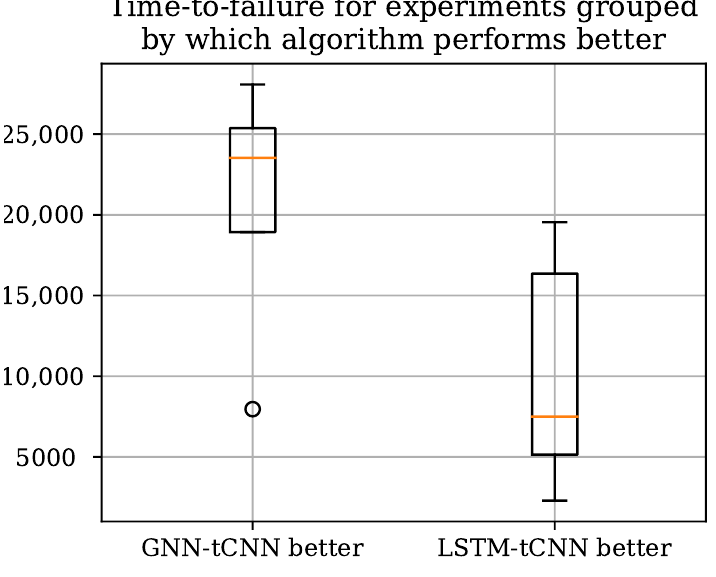
Figure 12. The total experiment times grouped by which RUL method performs better according to the MAE metric. The GNN-tCNN performs better for longer